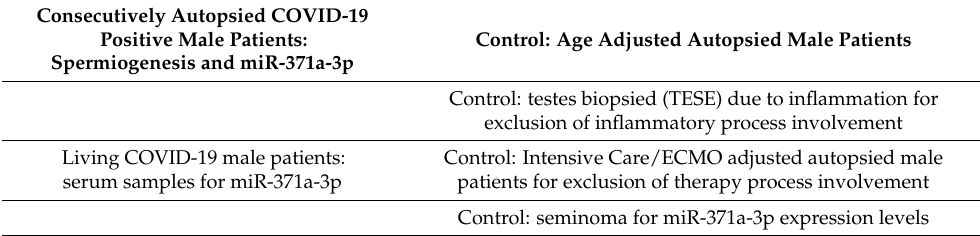
Table 1. Concluding the used samples and correlating controls.